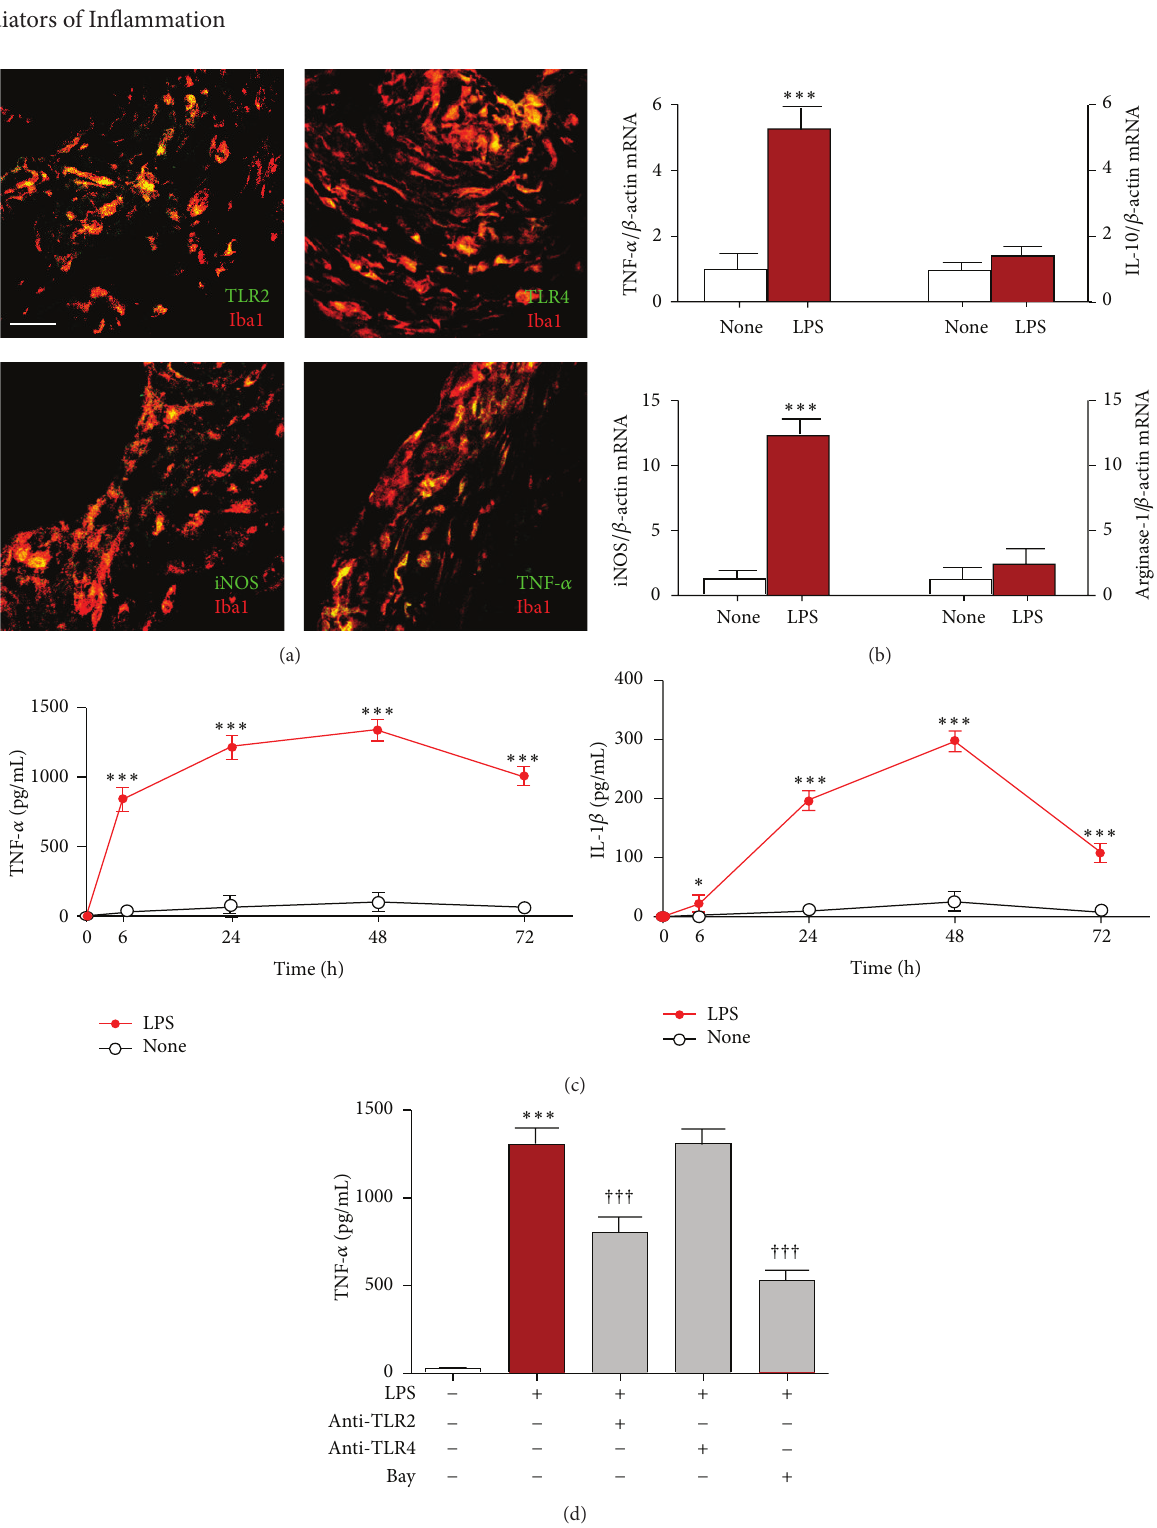
Figure 1: Characterization of macrophages in gingiva of chronic periodontitis patients and cultured macrophages after P.g. LPS stimulation. Immunofluorescent CLMS images of TLR2, TLR4, TNF- 𝛼 , and iNOS in gingiva of chronic periodontitis patients (a), scale bar = 20 𝜇 m. The mean mRNA levels of TNF- 𝛼 , IL-10, iNOS, and Arg I of THP-1 human monocyte-like cell line after P.g. LPS (LPS, 1 𝜇 g/mL) treatment for 24 h (b). Data are presented by mean ± SEM ( 𝑛 = 3 ), ∗∗∗ 𝑃 < 0.001 versus nontreated cells (none). Time course of TNF- 𝛼 and IL-1 𝛽 release in RAW264.7 mouse macrophages after P.g. LPS treatment (c). Data are presented by mean ± SEM ( 𝑛 = 4 , each), ∗∗∗ 𝑃 < 0.001 , ∗ 𝑃 < 0.05 versus nontreated cells (none). The LPS-induced TNF- 𝛼 secretion from RAW264.7 mouse macrophages at 48h with the neutralizing antibodies against TLR2 (10 𝜇 g/mL), TLR4 (10 𝜇 g/mL), or a specific NF- 𝜅 B inhibitor, Bay 11-7082 (Bay, 20 𝜇 M) (d). Data are presented by mean ± SEM ( 𝑛 = 4 , each), ∗∗∗ 𝑃 < 0.001 versus nontreated cells (none), and ††† 𝑃 < 0.001 versus P.g. LPS